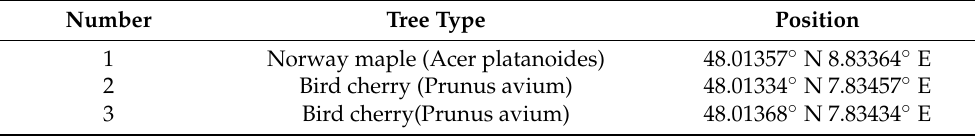
Table 1. Positions and types of trees that were used in the field experiment.